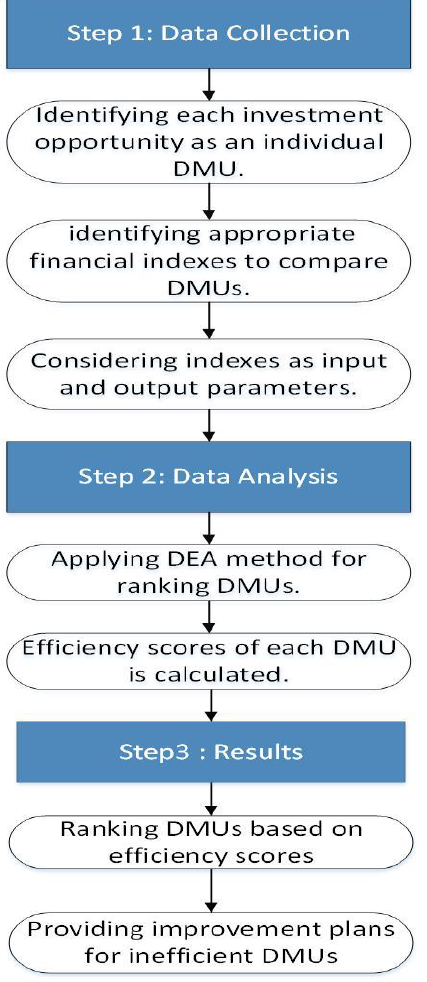
Figure 1. Procedure of